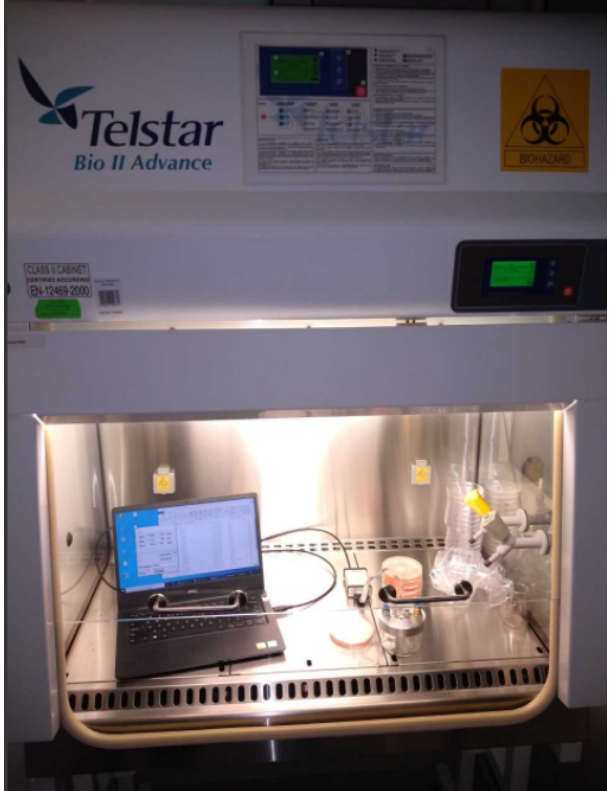
Figure 2. Measuring station with the low-cost electronic nose attached to a laptop inside the laminar flow